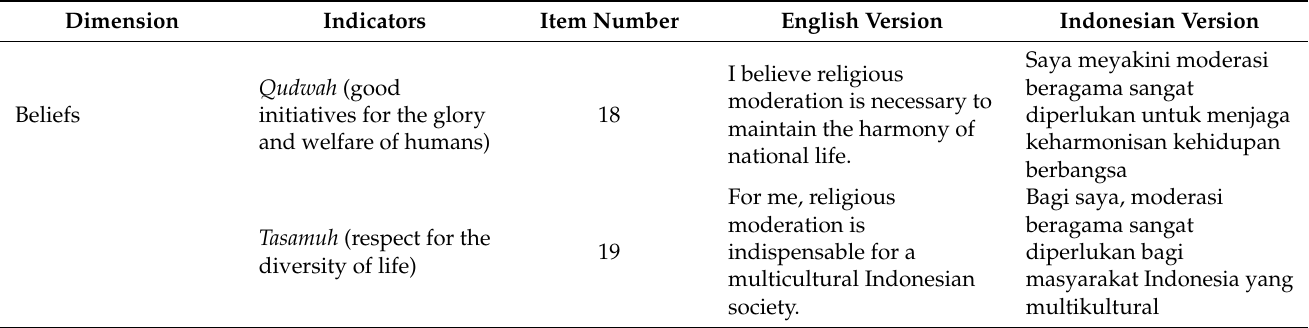
Table A2. Religious moderation